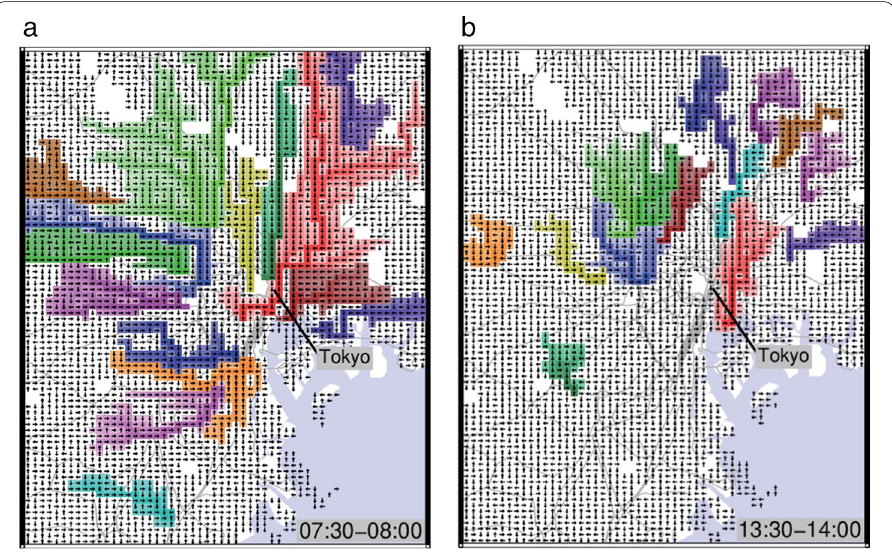
Fig. 3 Drainage basins around Tokyo metropolitan area during COVID-19 pandemic. a – b , Flow maps of basins in a the morning commuter rush hour (07:30–08:00) and b the afternoon (13:30–14:00) in the Tokyo metropolitan area, where the largest 15 basins are shown in different color codes. The display area is about 20 × 30 km. The analysis range is from April 7 to June 30,